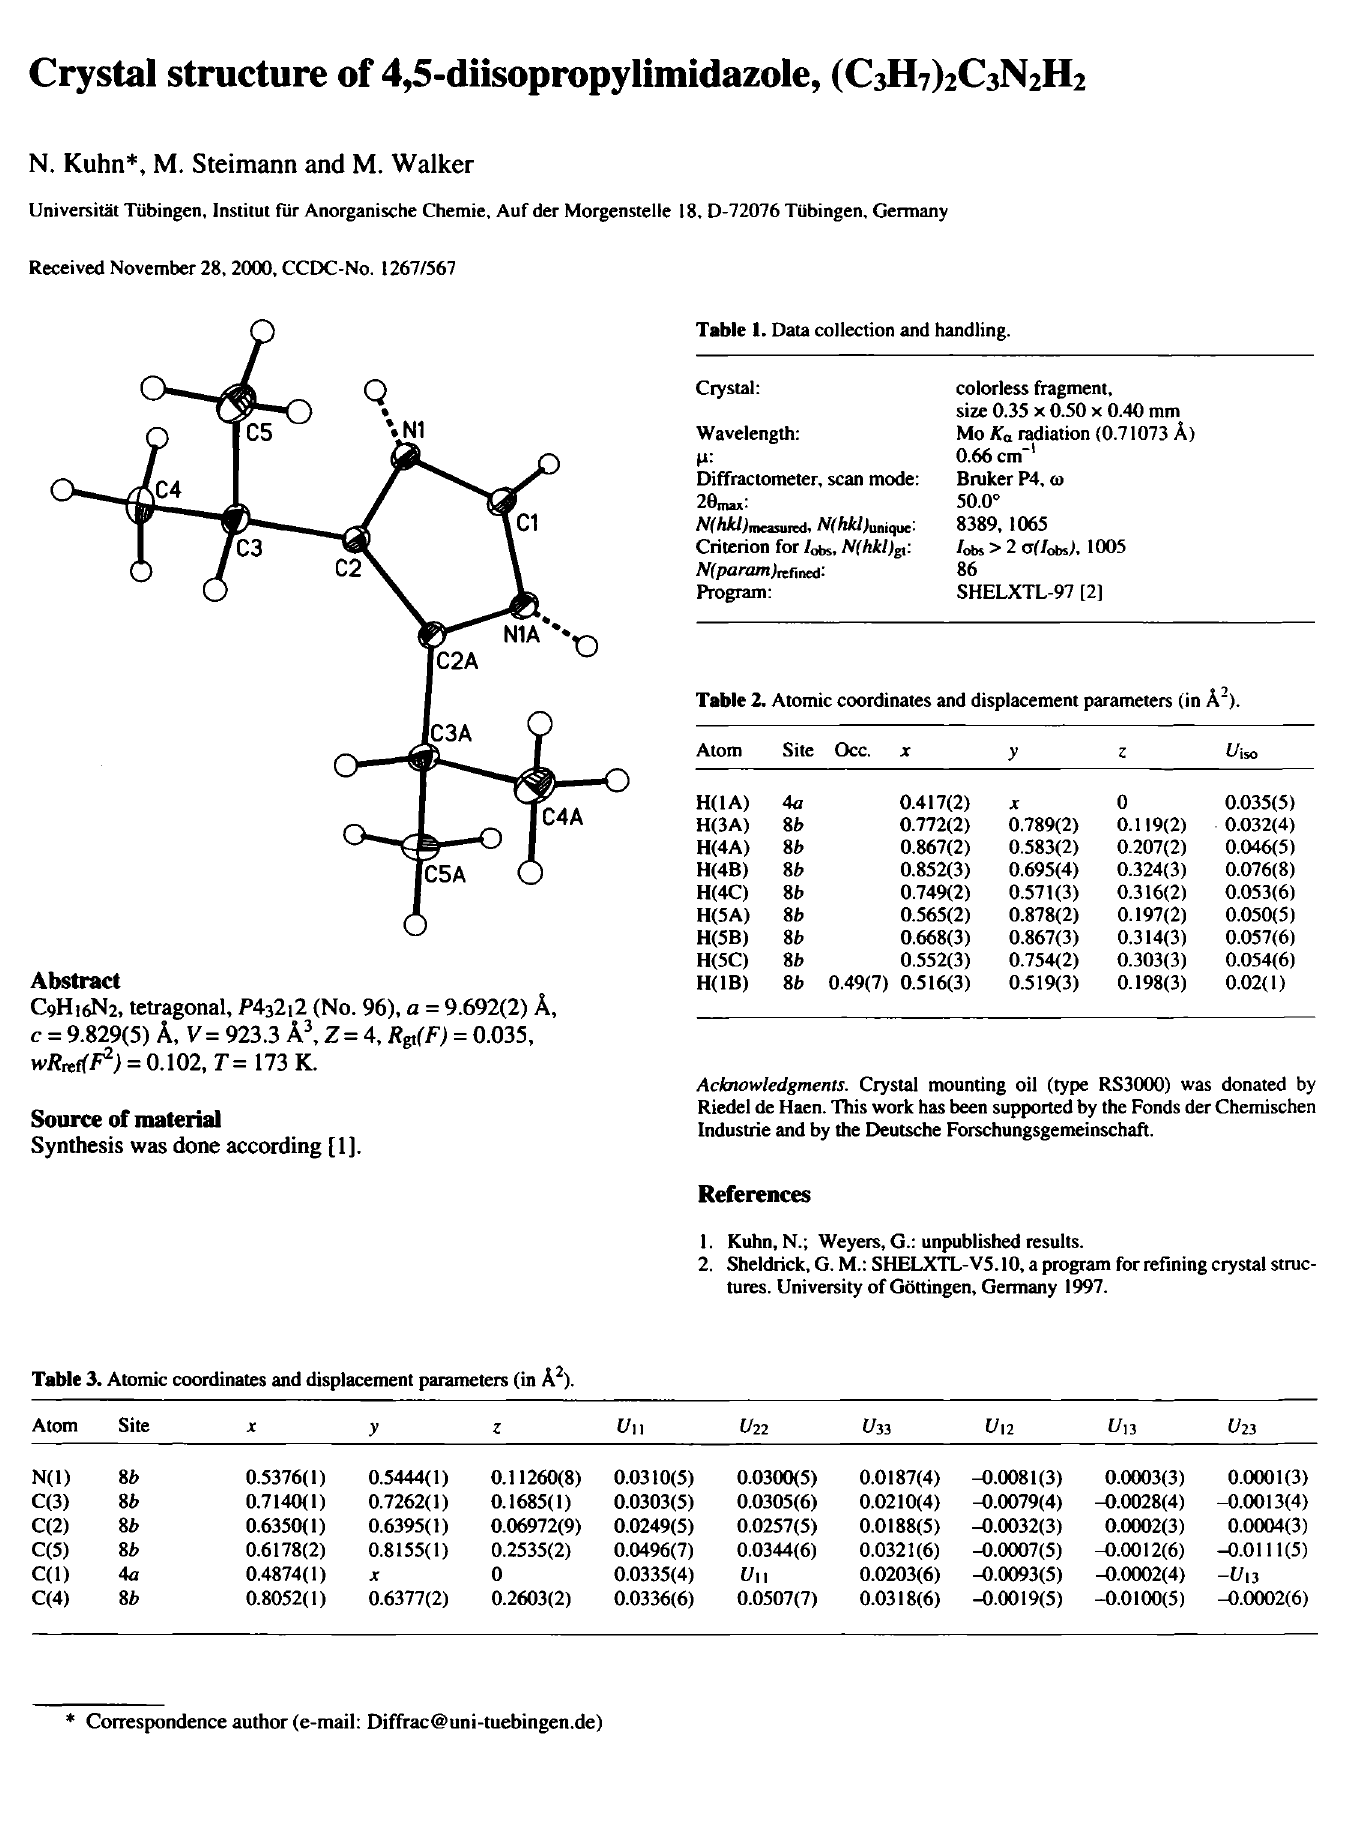
Table 3. Atomic coordinates and displacement parameters (in A 2